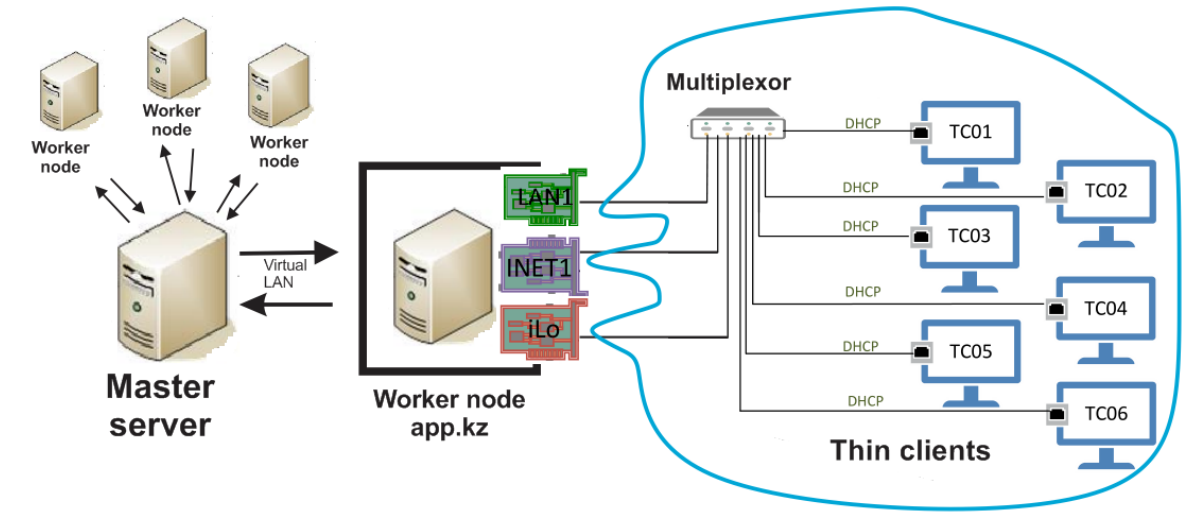
Figure 2. Architecture of the table simulator for DS